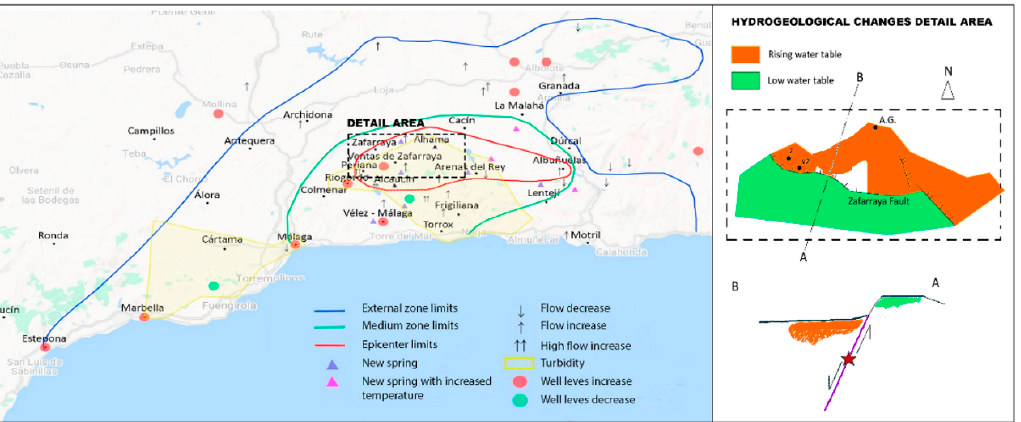
Figure 2. Alterations after the 1884 event. Left: map of the hydrogeological alterations produced. Right: diagram of the variation of the phreatic level (Right inset accronyms: Z, Zafarraya; VZ, Ventas de Zafarraya; A.G., Alhama de Granada).